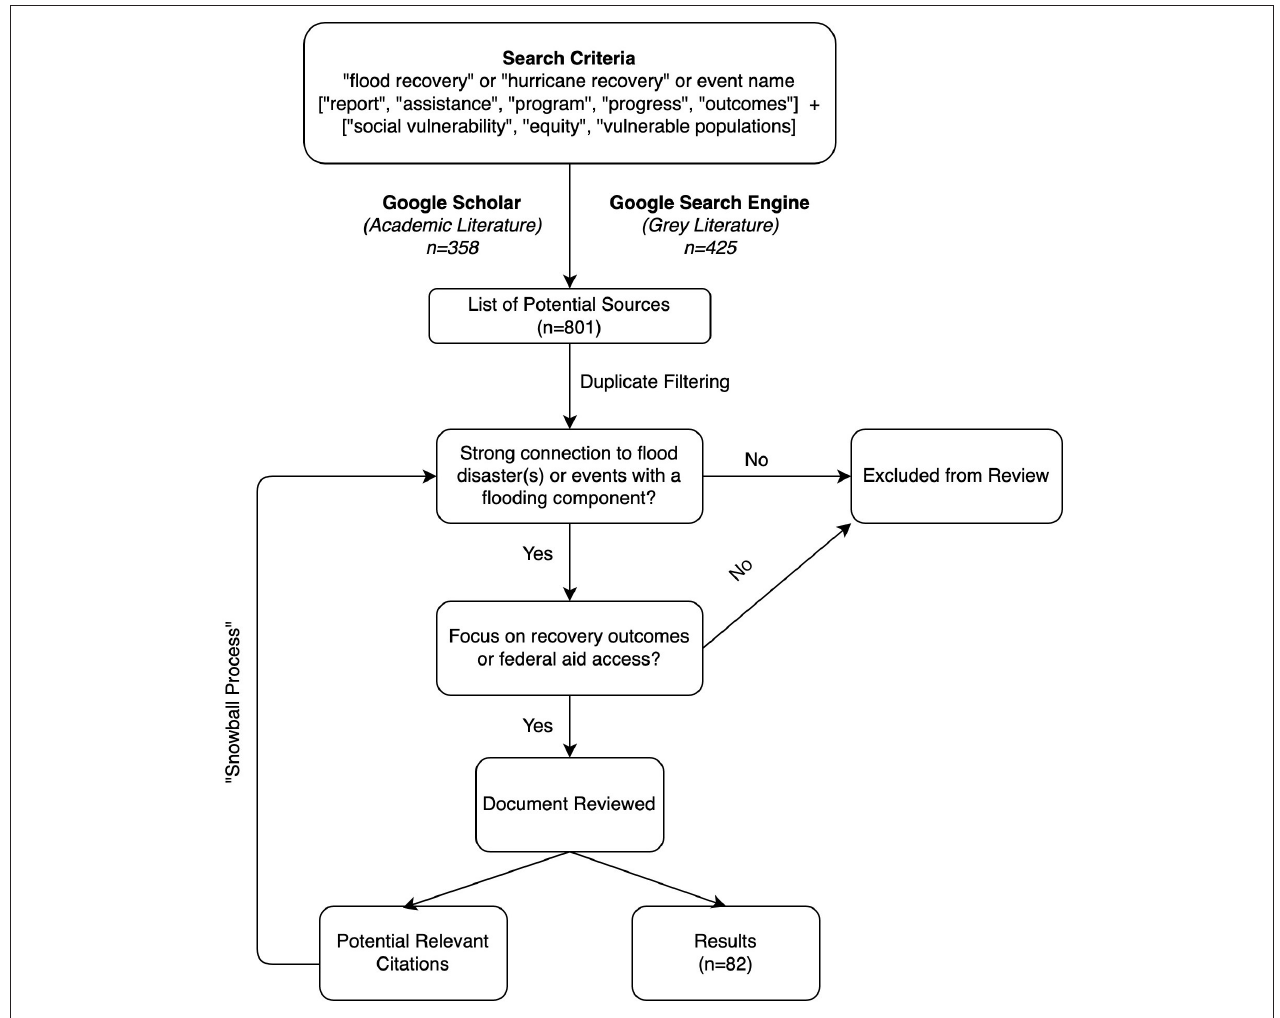
FIGURE 1 | Schematic overview of the review